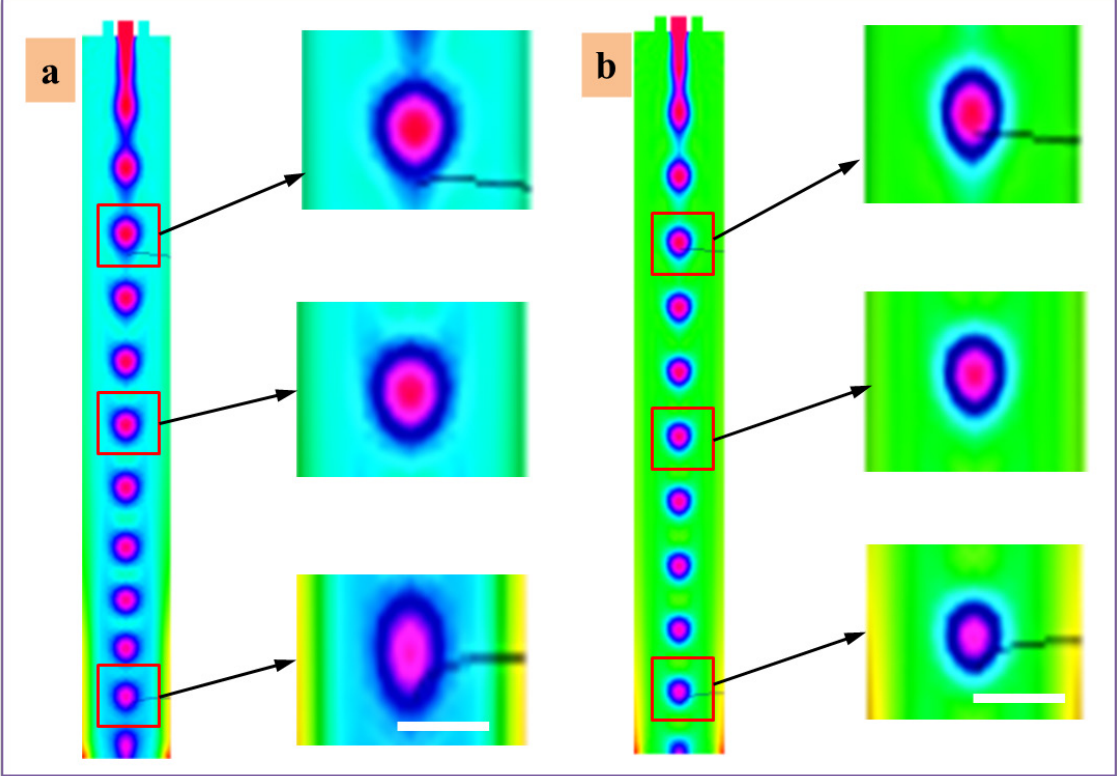
Figure 8. Representative droplet structures at shell/core flow velocity of ( a ) 150 m/s and dc pulse voltage of ( b ) 8.0 kV. Red color represents core fluids, blue color represents shell fluids, and green color is the surrounding air. Scale bar = 20 µm.